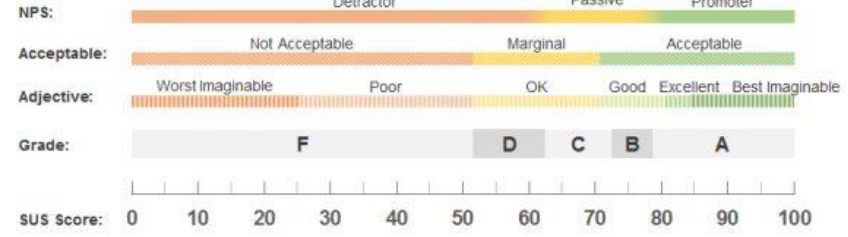
Fig. 8. Grades, adjectives, acceptability, and NPS categories associated with raw SUS scores [25]